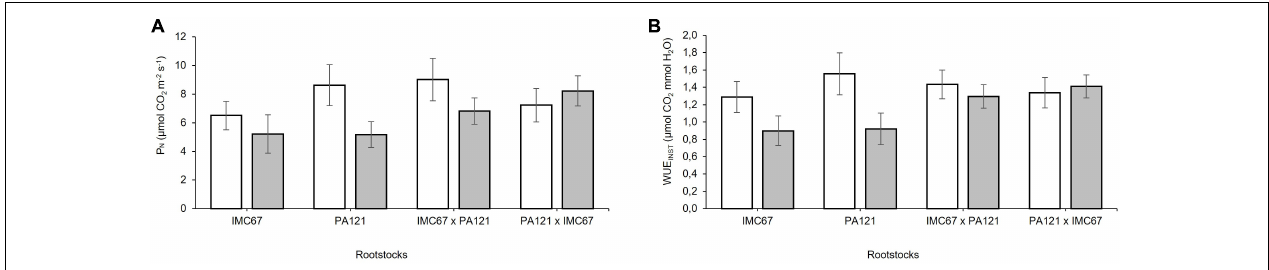
FIGURE 7 | Leaf gas exchange in four seedling rootstock families subjected to two different concentrations of Cd in soil under greenhouse conditions 5 months after cadmium treatment. (A) Photosynthetic rate (P N ), and (B) instantaneous water use efficiency (WUE INST ). White bars represent rootstock families grown in soil without addition of Cd (0.43 mg kg − 1 ). Gray bars represent rootstock families grown in Cd spiked soil (7.49 mg kg − 1 ). Data are mean values ± SE ( n = 8).